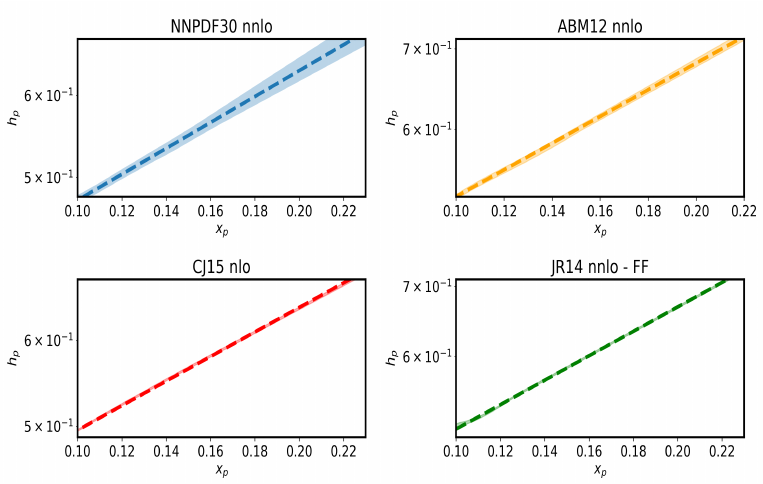
Figure 5. The peak position-height correlation for the PDF sets NNPDF 30 nnlo [14], ABM12 nnlo [15], CJ15 nlo [4] and JR14 nnlo-FF [16], as indicated, for valence u-quark. The shaded regions show the uncertainty at 68% confidence level while the dashed curves represent exponential fits for each PDF set.